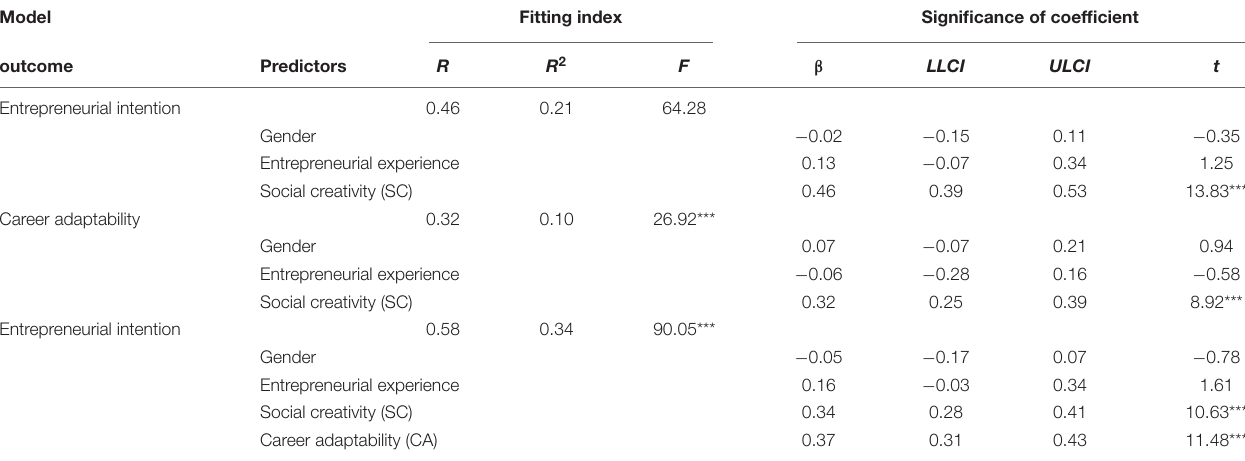
TABLE 2 | Testing the mediation model. Model Fitting index Significance of coefficient